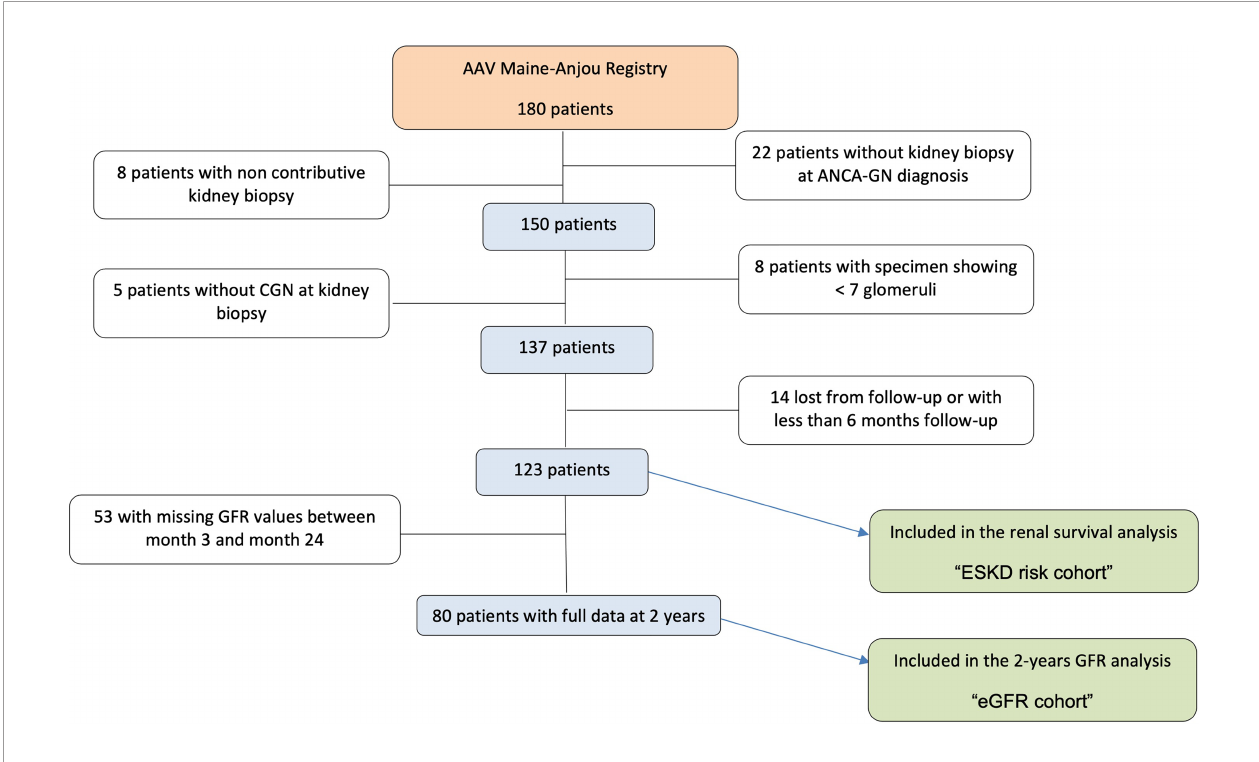
FIGURE 1 | Flowchart of the